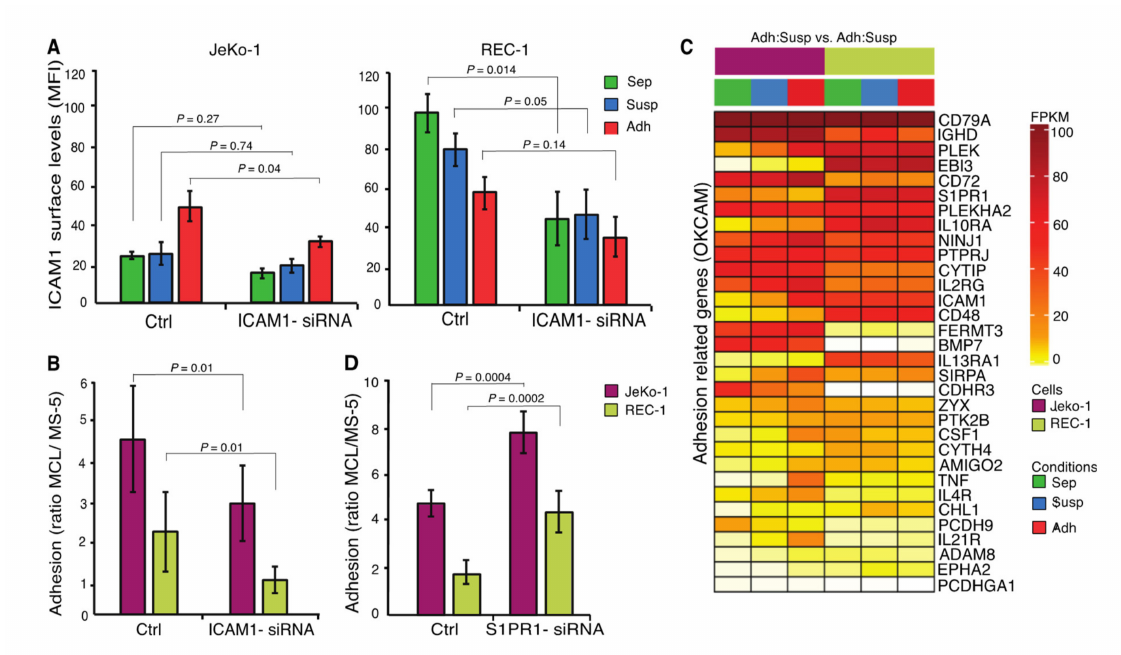
Figure 6. ICAM1 and S1PR1 are important for the adhesion of MCL cells to stroma ( A ) Membrane expression of ICAM1 in three di ff erent fractions of JeKo-1 and REC-1 cells without and with ICAM1-siRNA knockdown presented as mean fluorescent intensity. ( B ) MCL cells were cocultured with MS-5 stromal cells for 4 h without and with ICAM1 siRNA knockdown and the number of adherent cells was quantified using flow cytometry. ( n = 3 independent experiments and error bars represent SEM). ( C ) Transcript levels for significantly di ff erentially expressed genes (FDR q -value ≤ 0.05) involved in cell adhesion (Genes retrieved from the cell-adhesion database OKCAM (http: // okcam.cbi.pku.edu.cn)) for three di ff erent fractions of JeKo-1 and REC-1 cells, monocultured cells (Sep) in green, suspension cells in coculture (Susp) in blue and adherent cells in coculture (Adh) in red. ( D ) MCL cells were cocultured with MS-5 stromal cells for 4 h without and with S1PR1 siRNA knockdown and the number of adherent cells was quantified using flow cytometry. ( n = 3 independent experiments and error bars represent SEM). Student’s t -test was performed and the p value indicates di ff erences between the number of stromal cells adhered MCL cells in nontransfected and siRNA-transfected